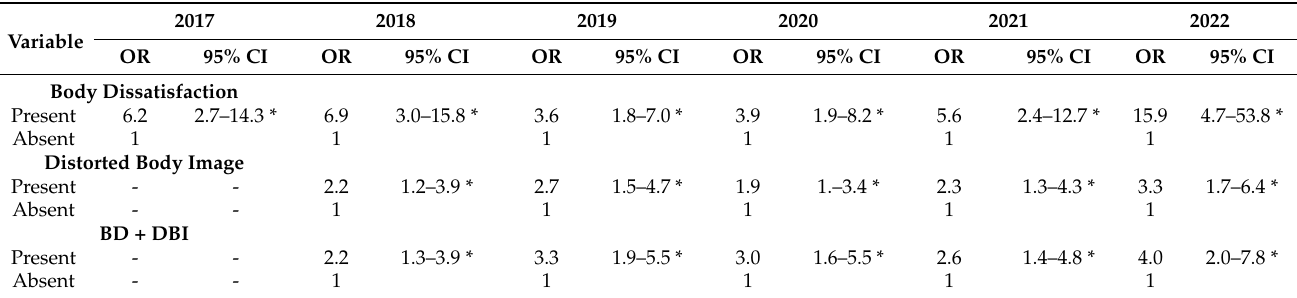
Table 3. Association between Body Dissatisfaction and Distorted Body Image with Disordered Eating Behaviors